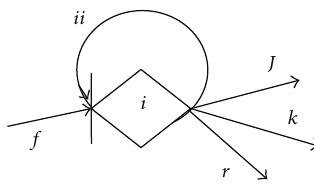
Figure 2: A display of delay